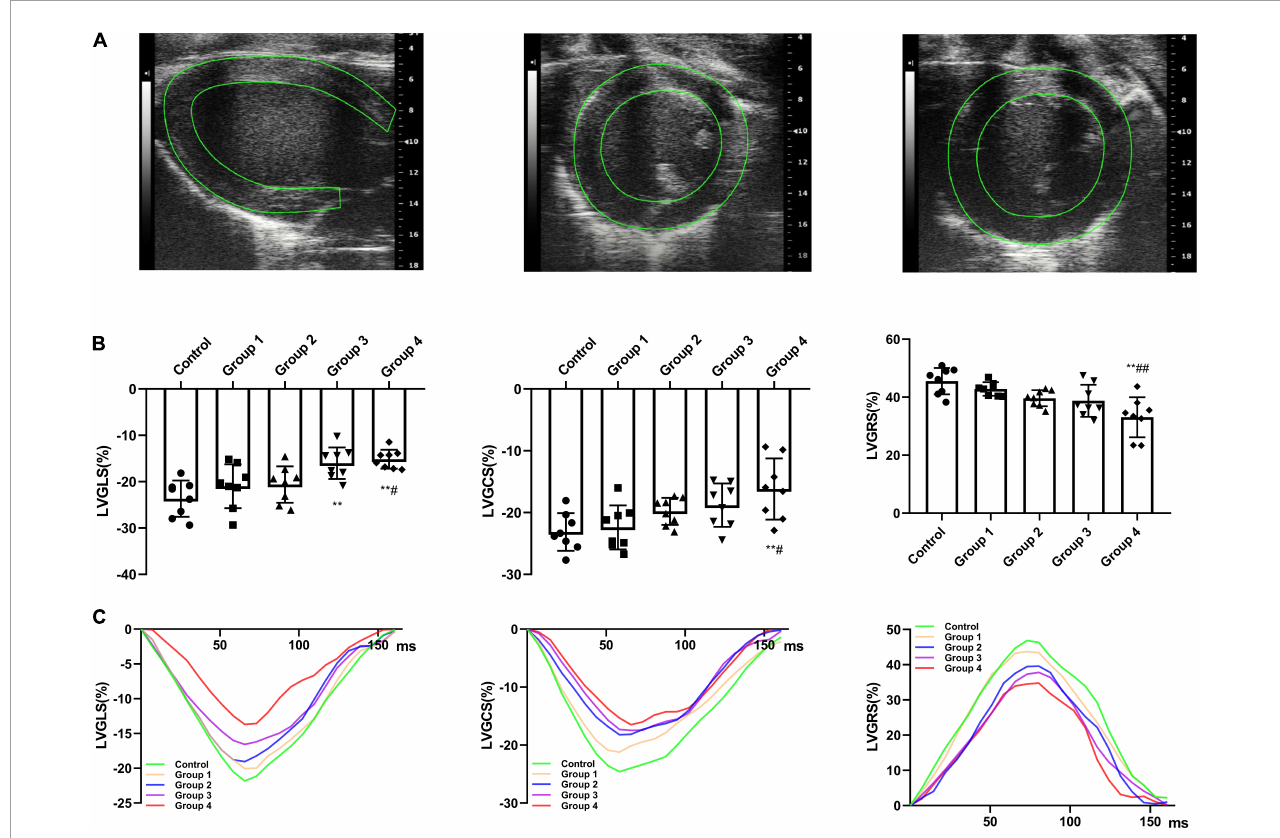
FIGURE2 DOX treatment impaired cardiac strain. (A) Representative long-axis strain and short-axis strain images [Representative long-axis strain and short-axis strain images (for GCS and GRS analysis, respectively)]. (B) GLS, GRS, and GCS between control and DOX groups ( n = 8). (C) Representative strain time curves of the five groups. LV, left ventricle; GLS, global peak longitudinal strain; GRS, global peak radial strain; GCS, global peak circumferential strain; The data are expressed as the means ± SDs. ** p < 0.01 versus control, # p < 0.05 versus Group 1, ## p < 0.01 versus Group